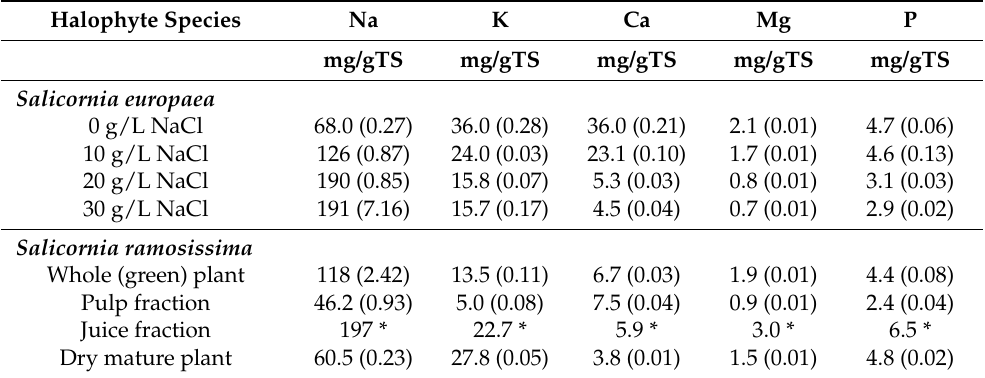
Table 2. Mineral content of Salicornia samples in mg/gTS, standard deviation of triplicates in